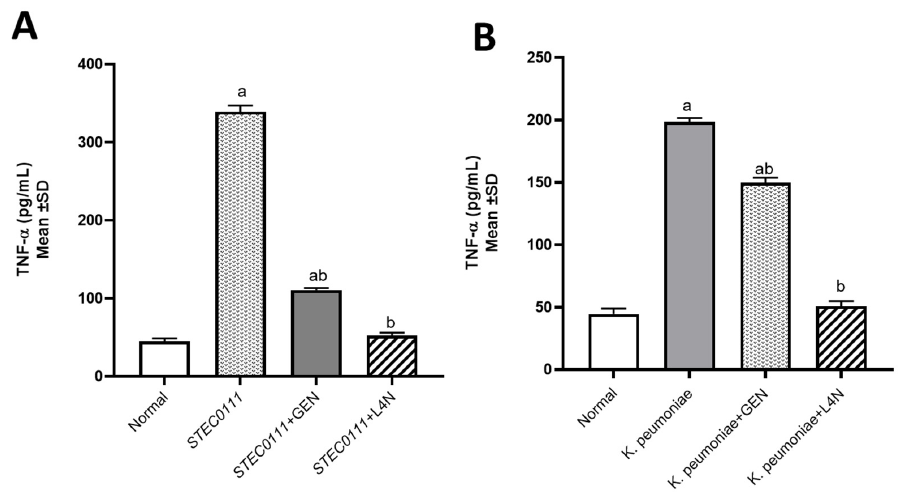
Figure 3. Tumor necrosis factor-alpha (TNF- α , pg/mL) levels in mice infected with MDR K. pneumoniae ( A ) and E. coli O111 ( B ) and then treated with luteolin 4 ′‐ neohesperidoside (L4N) and gentamycin (GEN). a Significant difference from normal control group at p < 0.05. b Significant difference from infected group at p < 0.05. ab Significant difference from normal control group and infected group at p < 0.05.